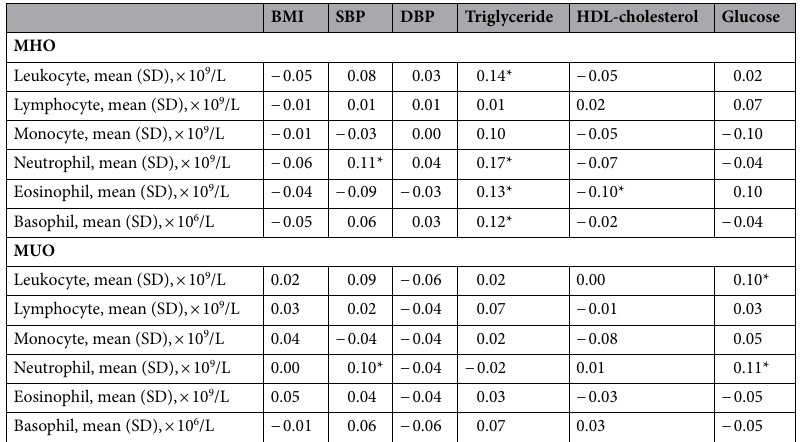
Table 4. Correlations between metabolic risk factors and leukocyte-related parameters from MHO and MUO elders. Adjusted for age, sex, smoking, tea consumption, alcohol consumption, and education level. BMI body